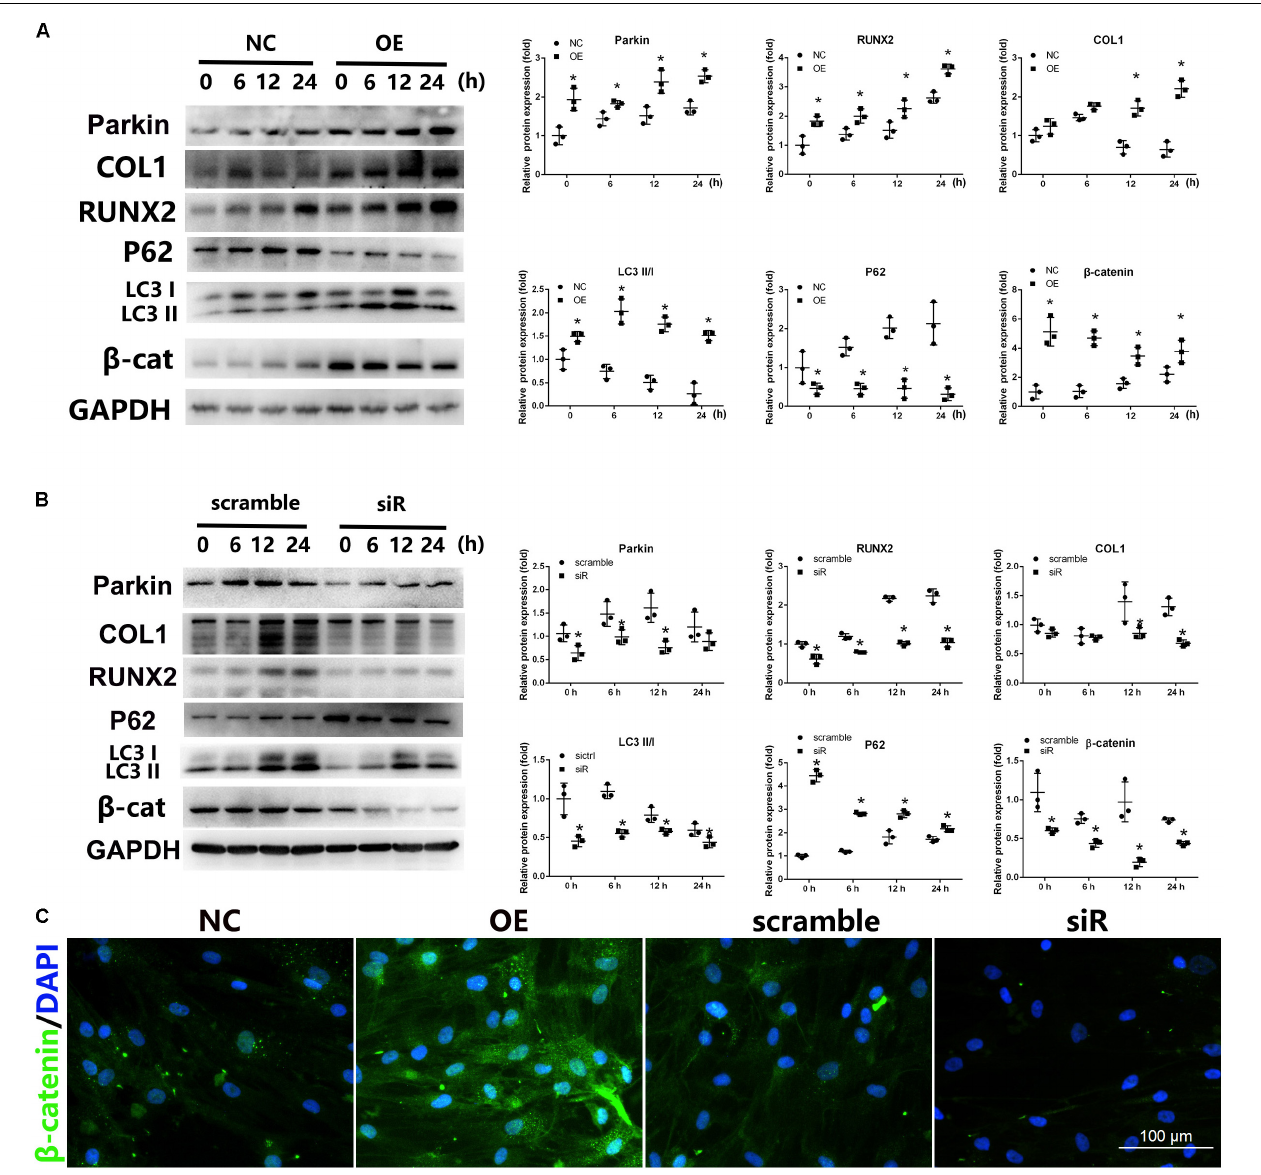
FIGURE 3 | Expression of Wnt/ β -catenin and autophagy signaling after upregulation or downregulation of Parkin during osteogenic differentiation of BMSCs. (A) When Parkin was overexpressed, protein levels of Parkin, COL1, RUNX2, LC3, p62, β -catenin, and GAPDH were determined by WB analysis after osteogenic differentiation for 0, 6, 12, and 24 h. Protein expression levels were normalized to GAPDH. Data are expressed as the mean ± SD of three independent experiments, and one of three independent experiments is shown. (B) When Parkin was downregulated by siRNA, the expression levels of Parkin, COL1, RUNX2, LC3, p62, β -catenin, and GAPDH protein were determined by WB analysis after osteogenic differentiation for 0, 6, 12, and 24 h. Protein expression levels were normalized to GAPDH. Data are expressed as the mean ± SD of three independent experiments, and one of three independent experiments is shown. (C) Expression of β -catenin was analyzed by immunofluorescence staining at day 1 after osteogenic induction. * P < 0.05 vs. BMSCs treated with osteogenic induction medium alone. Magnification ×